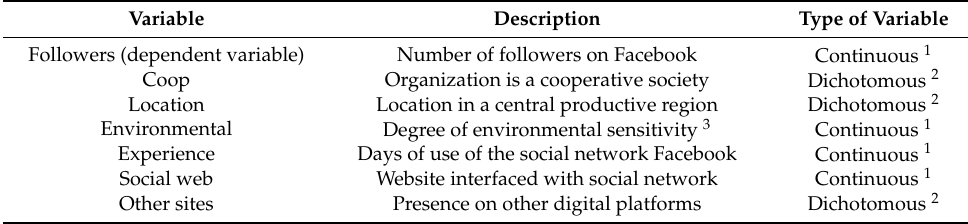
Table 1. Description of the variables used in this study.